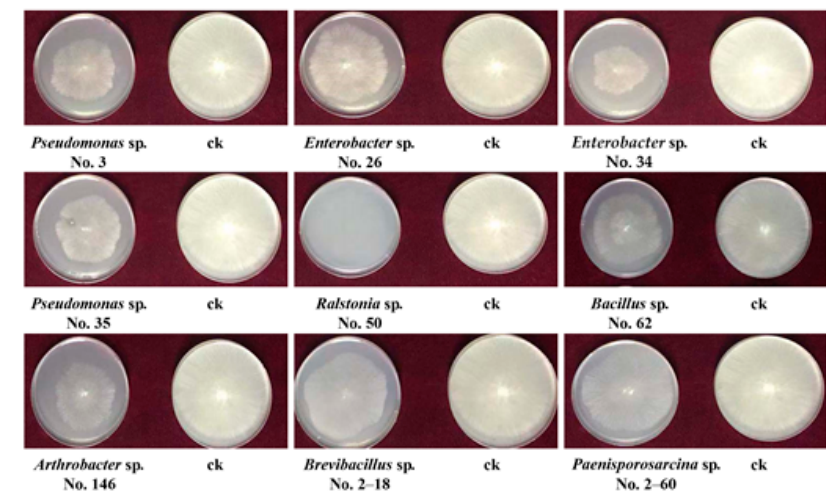
Figure 1. ( A ): Inhibition rate of different bacteria against Rhizoctonia solani . The inhibition rate was measured with the following formula: Inhibition rate = (The colony diameter of control R. solani − The colony diameter of treated R. solani )/The colony diameter of control R. solani × 100%. ( B ): Pictures of R. solani treated with volatile organic compounds (VOCs) from different bacteria. ck: R. solani treated with uninoculated beef extract peptone medium.